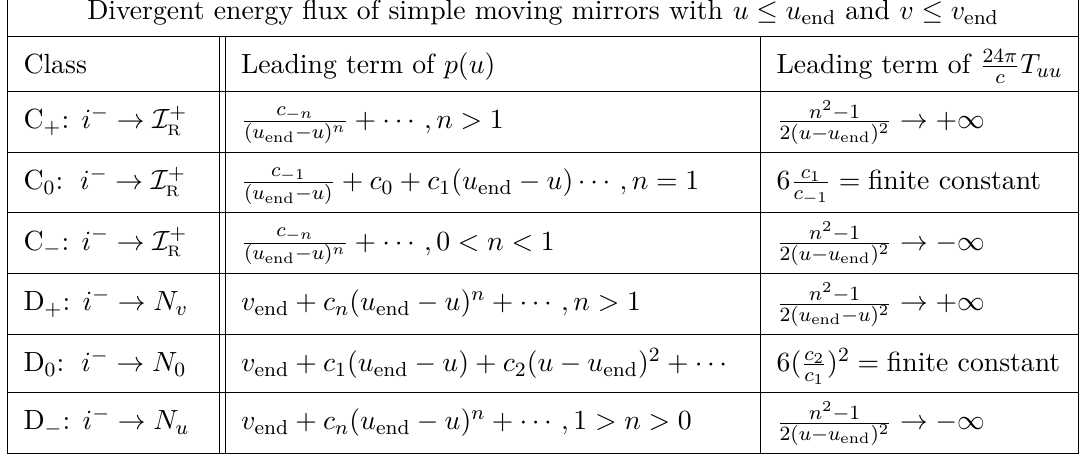
Table 3 . The leading behavior of the function p ( u ) and the stress tensor T uu near the endpoints for various moving